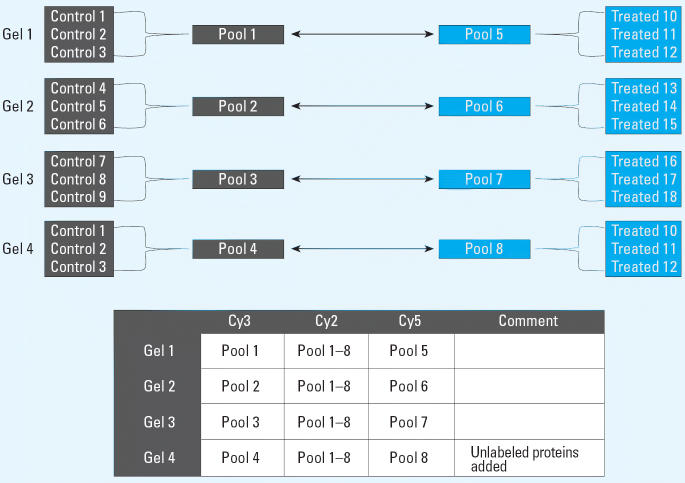
Experimental design and pooling procedure. Individual control (1–9) and treated (10–18) tissue samples were separately pooled into three control (1–3) and treated (5–7) pools per sample type (striatum and hippocampus). In addition to these biological replicates, we made a technical replicate of pools 1 and 5 (4 and 8, respectively). Control pools (1–4) were labeled with Cy3, treated pools (5–8) with Cy5, and a mixture of all pools (pools 1–8) with Cy2 as internal standard. Four gels were run in parallel, as indicated, with extra unlabeled protein added to gel 4.